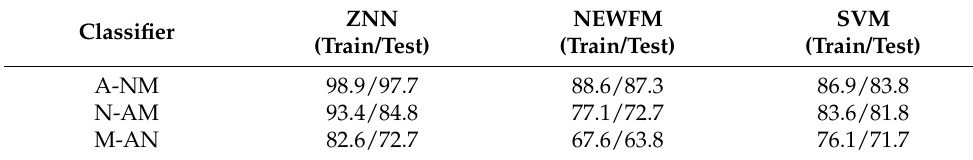
Table 2. Performance comparisons of different classifiers for three AD assessments (%).